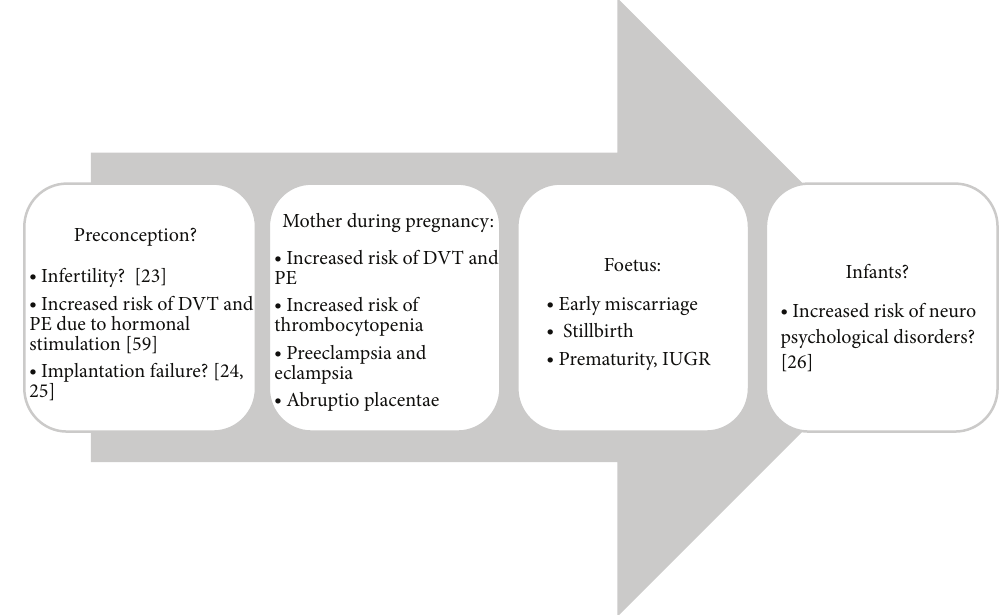
Figure 1: Obstetrical APS pathologies: more than a single